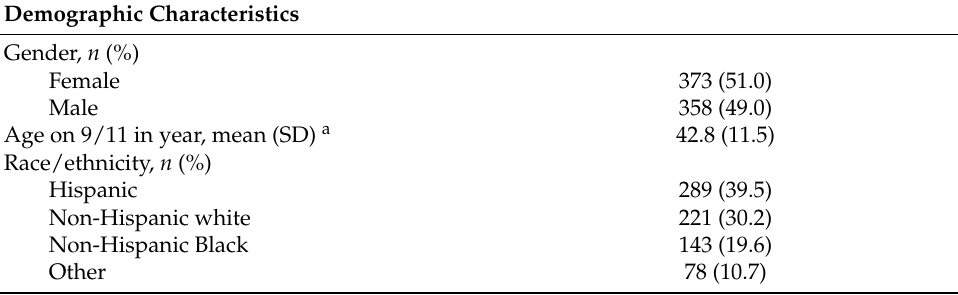
Table 1. Patient characteristics ( n =